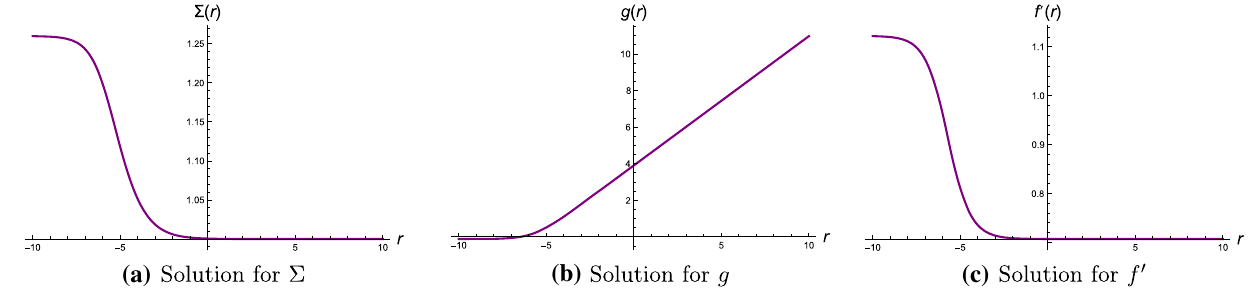
Fig. 2 An RG flow between N = 4 AdS 5 vacuum with U ( 1 ) × SU ( 2 ) × SU ( 2 ) symmetry and N = 4 AdS 3 × H 2 vacuum with U ( 1 ) × U ( 1 ) diag symmetry in (97) for g 1 =